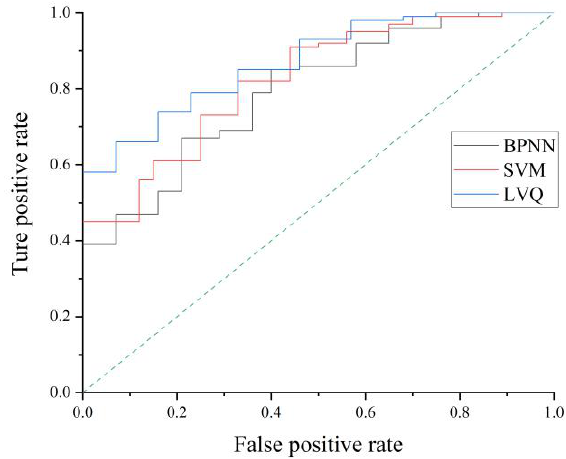
Figure 17. ROC curves of three